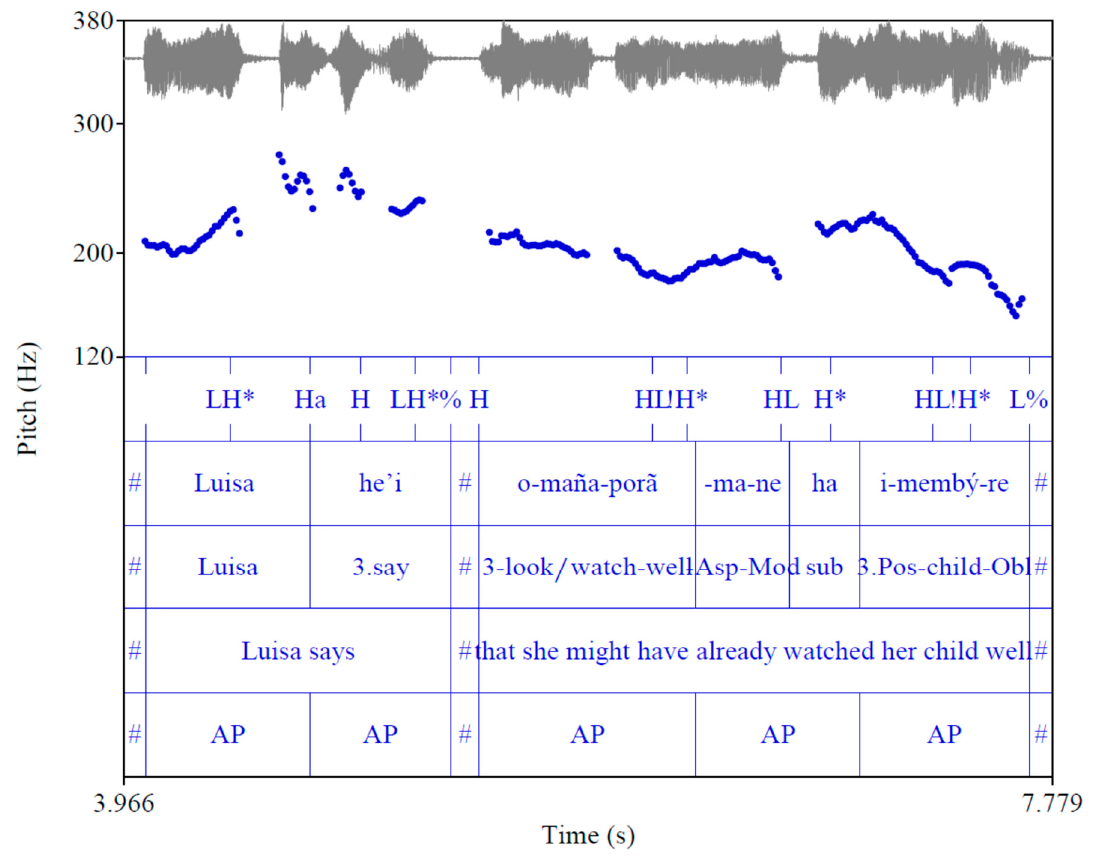
Figure 3. Luisa omañaporãmaneha imembýre.